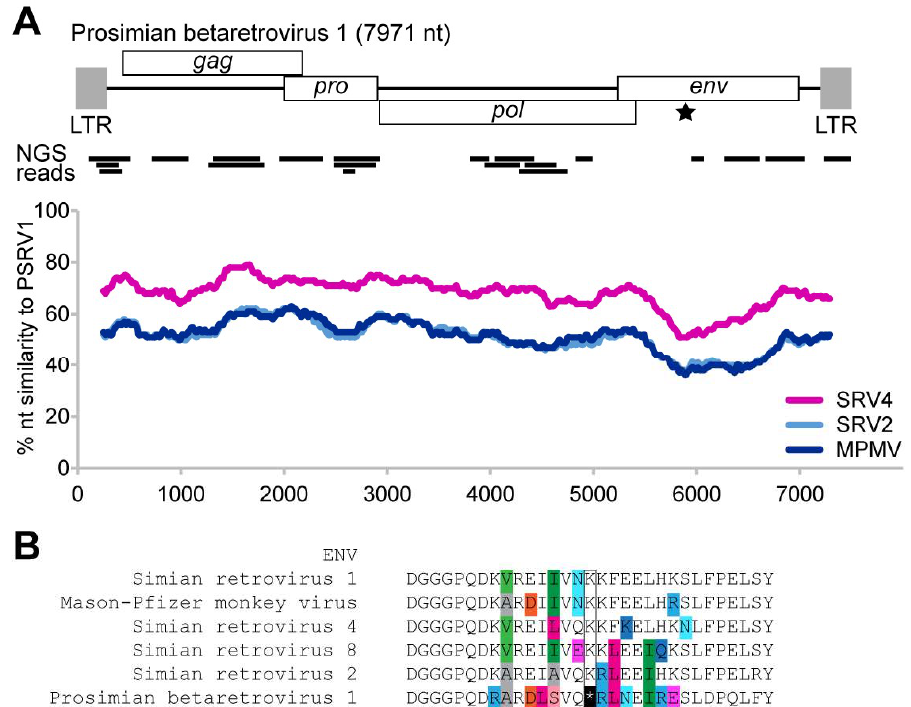
Figure 1. The prosimian retrovirus 1 (PSRV1) genome and its sequence similarity to closely related retroviruses simian retrovirus (SRV) 2, SRV4, and Mason–Pfizer monkey virus (MPMV). ( A ) PSRV1 encodes four open reading frames: gag , pol, pro, and env . A single premature stop codon was found in the env gene (marked by a star). Initial Illumina next-generation sequencing (NGS) reads mapping to PSRV genome are indicated in black bars below. ( B ) Sequence alignment of the Env protein shows that the premature stop codon position is otherwise a highly conserved lysine amino acid in other betaretroviruses.